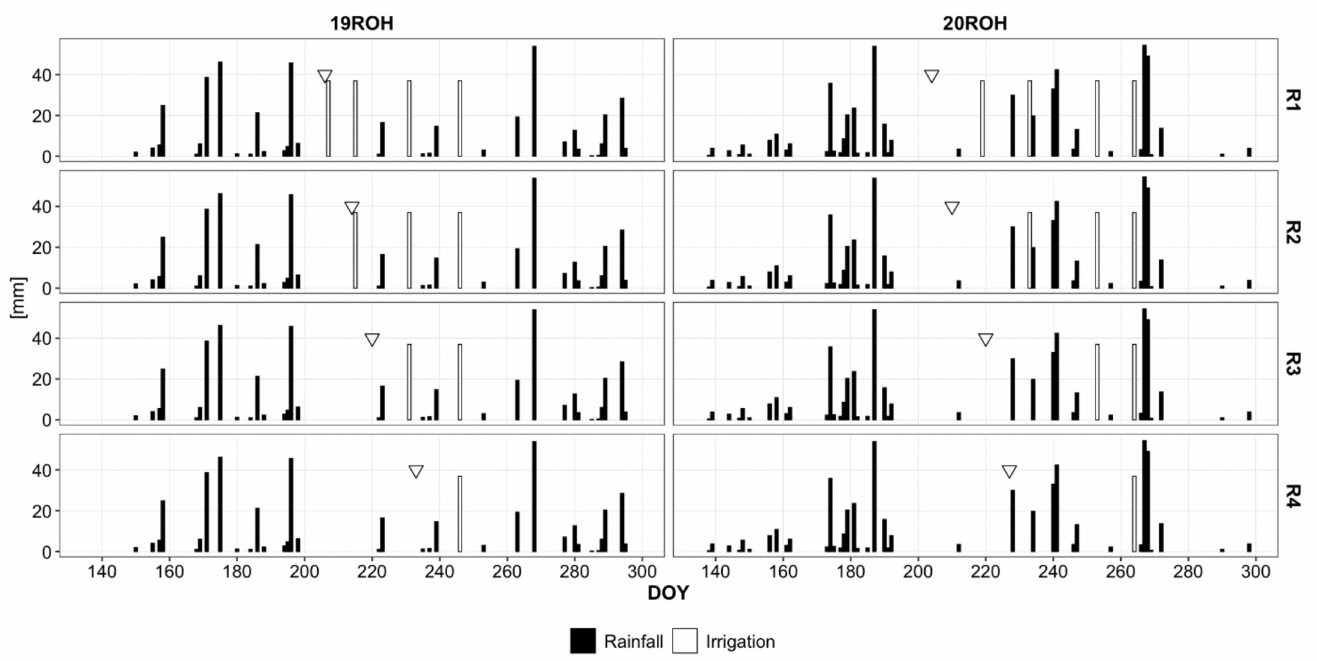
Figure 2. Daily distribution of rainfall and irrigation (mm) during the two growing seasons (2019 and 2020) in Rohwer (ROH). DOY: day of the year. The symbol indicate the time of canopy wilting rating.